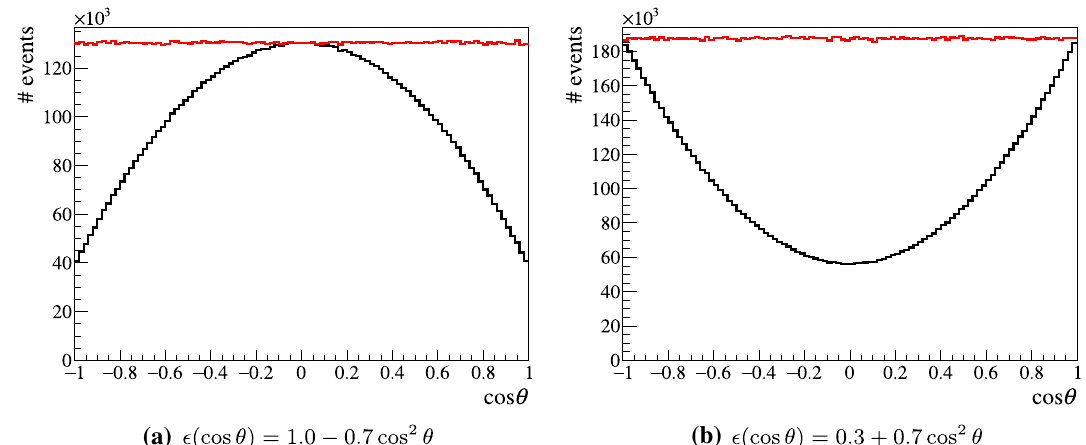
Fig. 1 Angular cos θ distribution of (black) data and (red) efficiency corrected events for 10000 pseudoexperiments consisting of 1000 events